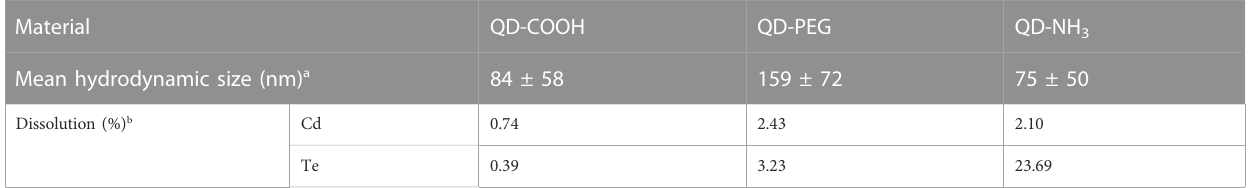
TABLE 3 Hydrodynamic size (nm) distribution and metal dissolution (mg/L) of 100 mg/L CdTe QDs stock solutions after 24 h in ultrapure water as analysed by Plymouth University for the Nanosolutions project (±SD).